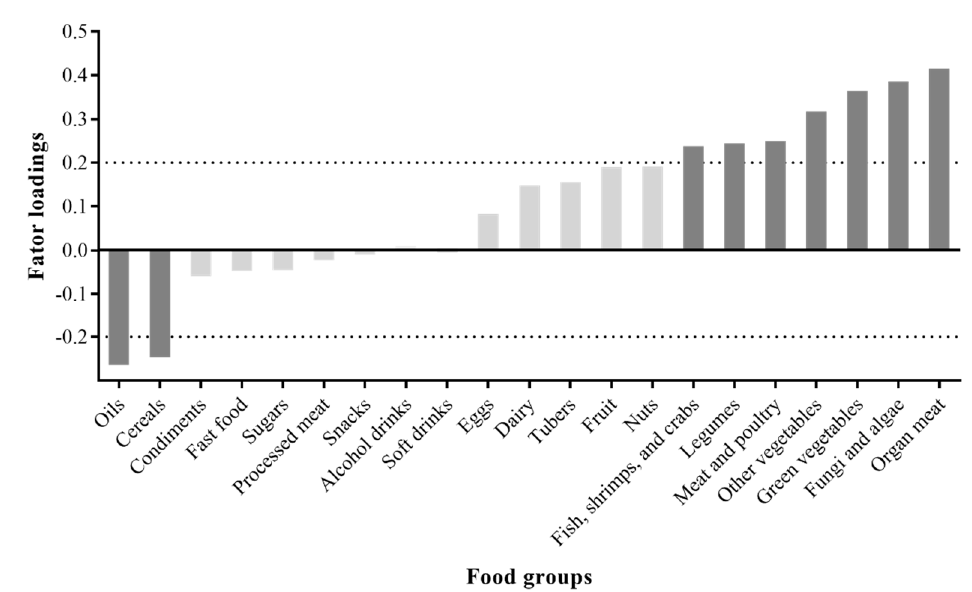
Figure 1. Factor loading of the food groups in the high B-vitamin dietary pattern score. Dark grey indicates absolute factor loading value ≥ 0.2. Table 1. Associations between the dietary pattern score derived by reduced rank regression and B vitamins intakes.